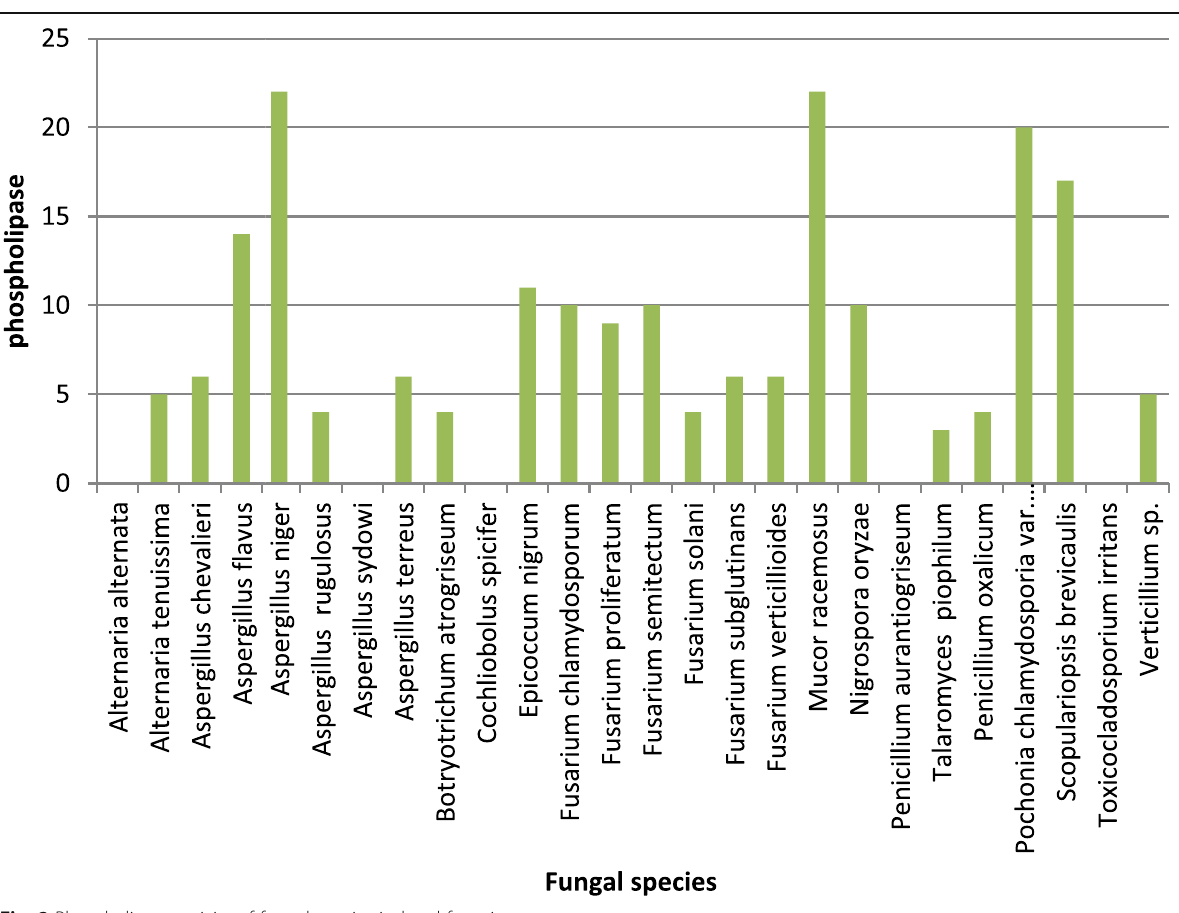
Fig. 2 Phospholipase activity of fungal species isolated from